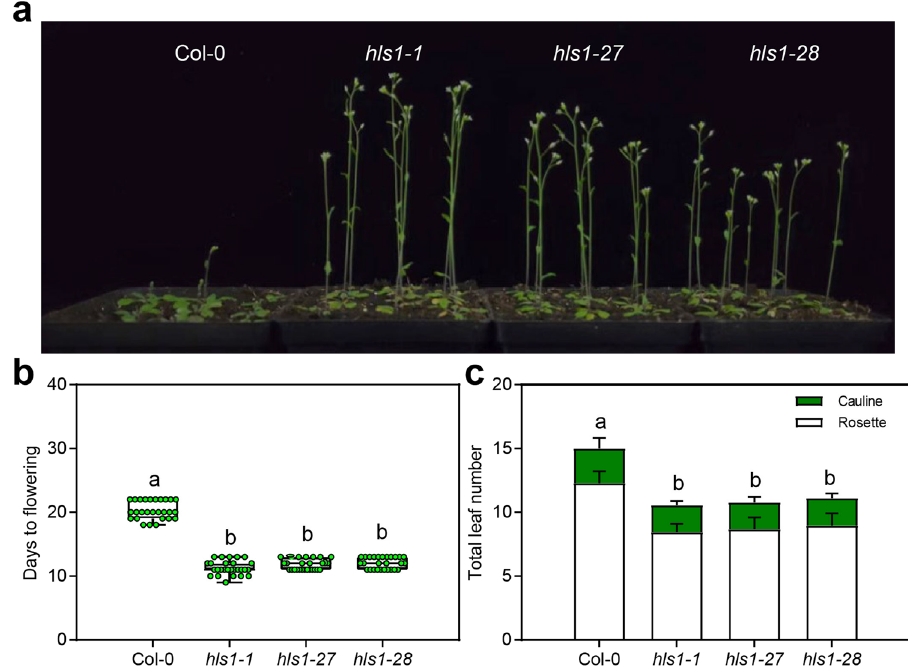
Fig. 2 HLS1 delays fl owering in Arabidopsis thaliana . a Images show representative fl owering phenotypes of 22-day-old plants grown under LD conditions (16 h light/8 h dark). b Statistical analysis of the days from germination to fl owering under LD conditions. Signi fi cant differences were determined by one- way analysis of variance (ANOVA) and post hoc Tukey ’ s test, with different lowercase letters indicating signi fi cant differences (data are means± SD; n = 27, P < 0.05). c Statistical analysis of the total leaf number under LD conditions. Signi fi cant differences were determined by two-way analysis of variance (ANOVA) and post hoc Tukey ’ s test, with different lowercase letters indicating signi fi cant differences (data are means ± SD; n = 27, P <